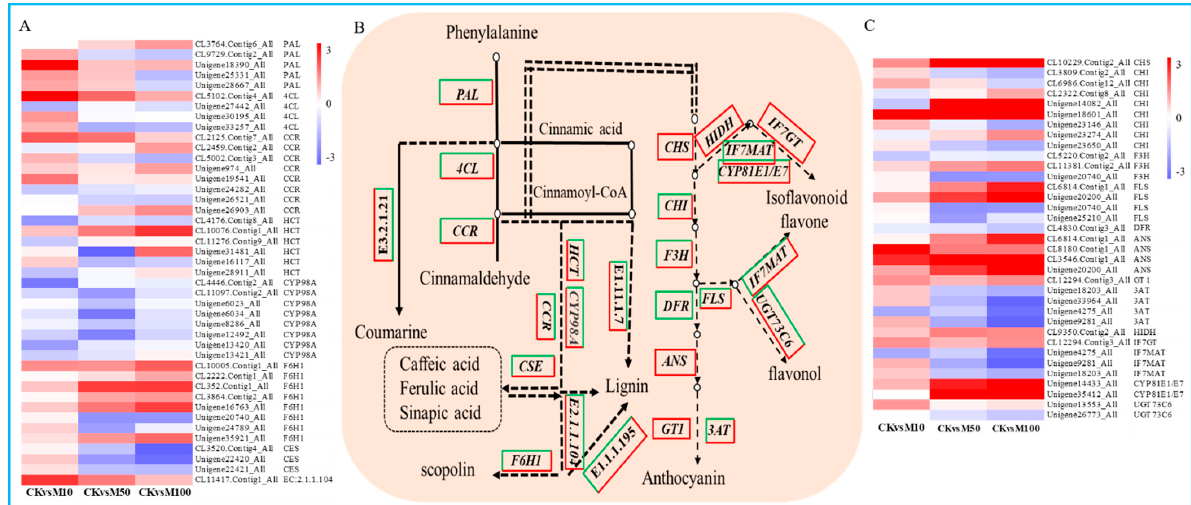
Figure 5. DEGs assigned to phenylpropanoid and flavonoid biosynthesis pathways under MeJA treatments. ( A ) heat map of the expression of DEGs in phenylpropanoid biosynthesis. ( B ) simplified diagram of phenylpropanoid and flavonoid biosynthetic pathway. ( C ) heat map of the expression of DEGs in flavonoid